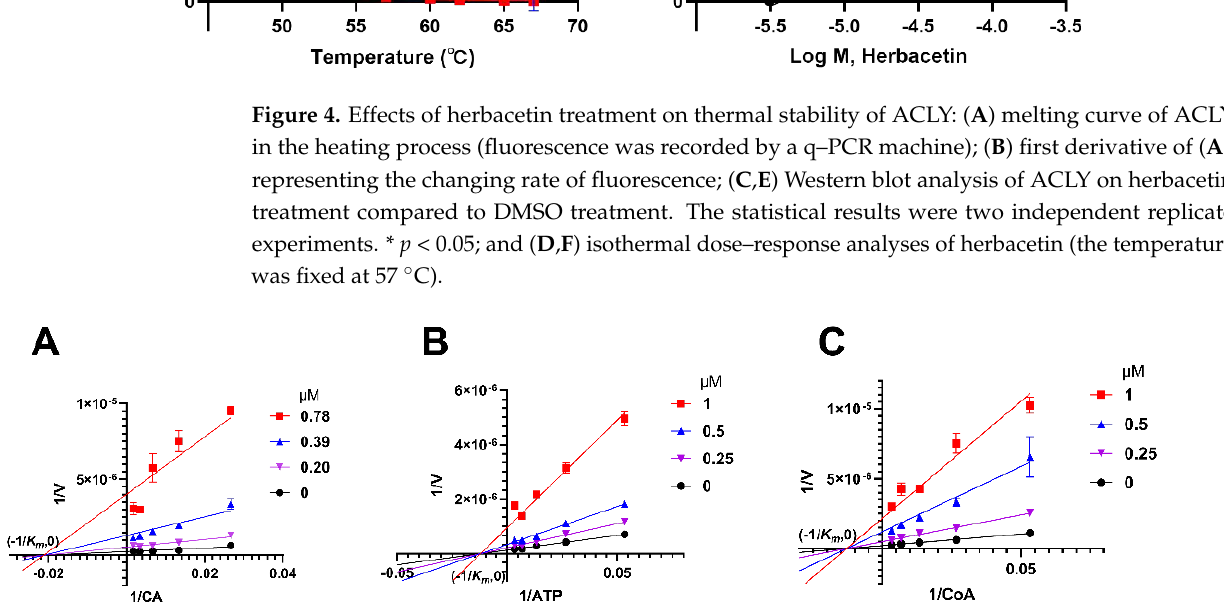
Figure 5. Kinetic studies of herbacetin. Double reciprocal curves were plotted when CA ( A ), ATP ( B ) or CoA ( C ) served as a